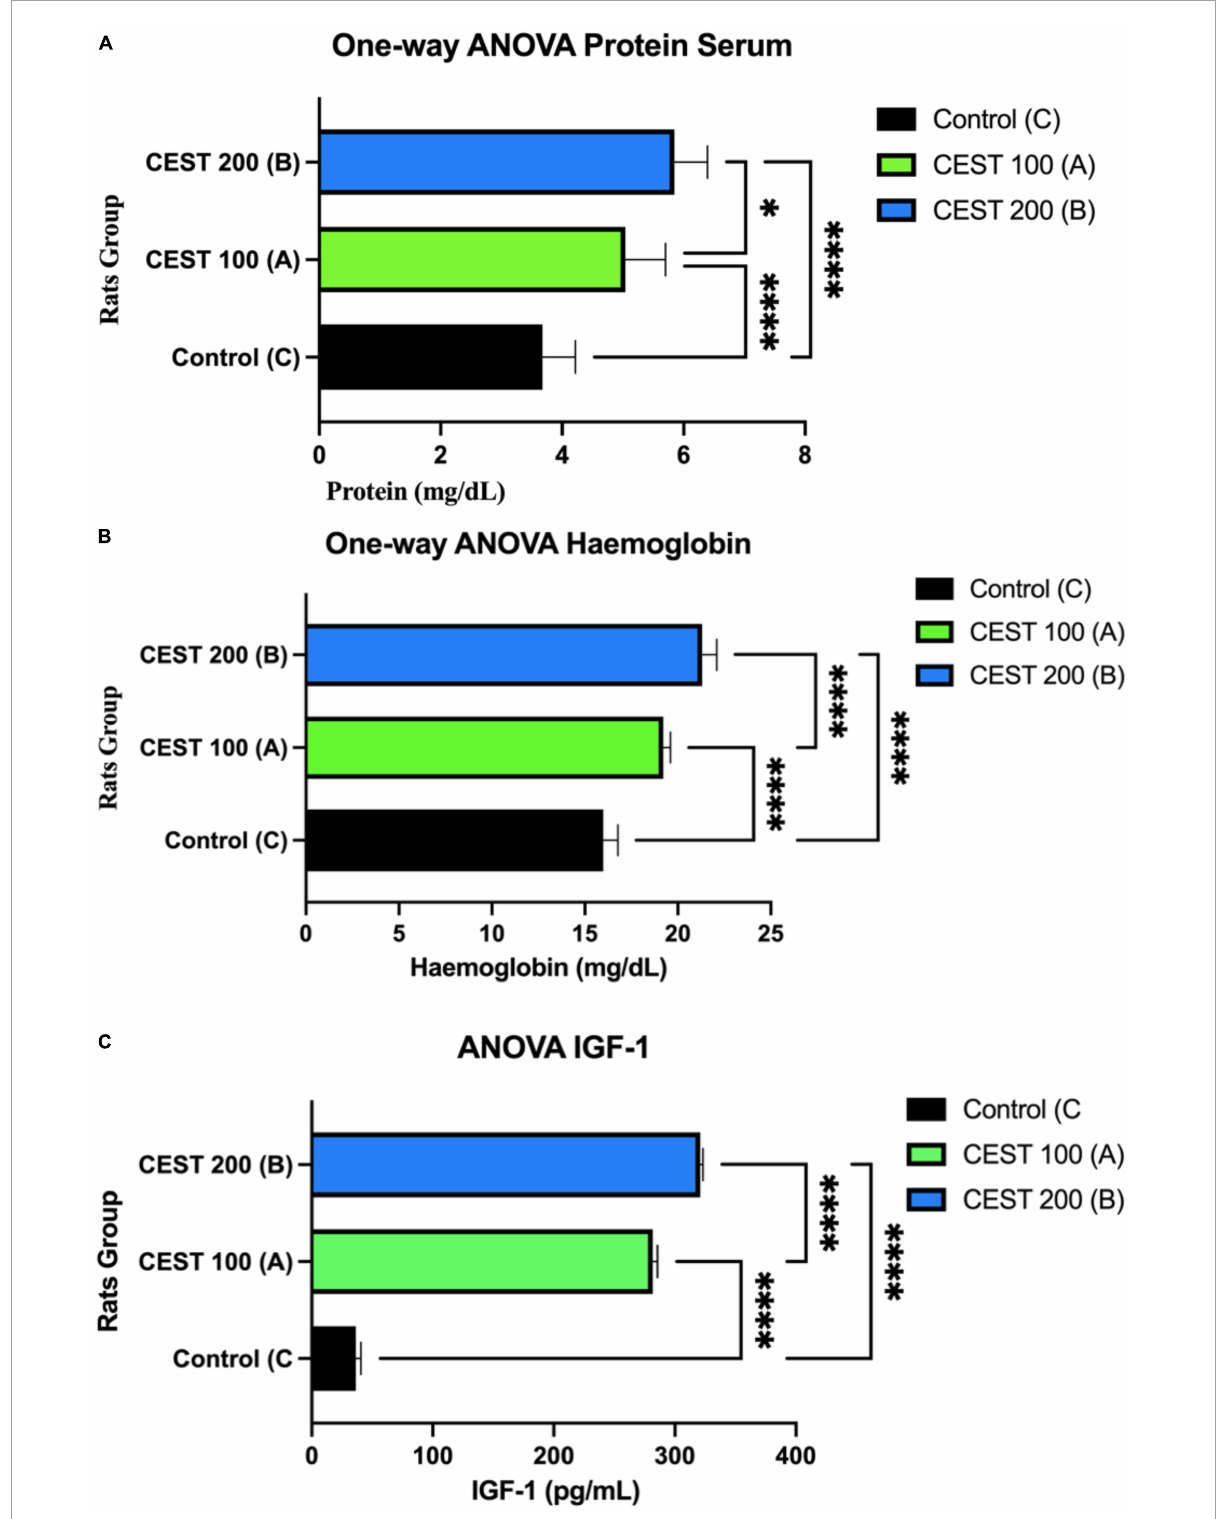
FIGURE3 A higher dose of CEST significantly improves the level of serum protein, hemoglobin, and insulin-like growth factor I (IGF-1). (A) Comparison of serum proteins between treatment groups with ∗ is the value p = 0.0128. (B) Comparison of hemoglobin between treatment groups. (C) Comparison of hemoglobin between groups of IGF-1 treatment, which indicates significance p < 0.0001 (One-way ANOVA Test; 95% CI). The figure was using a legal and licensed